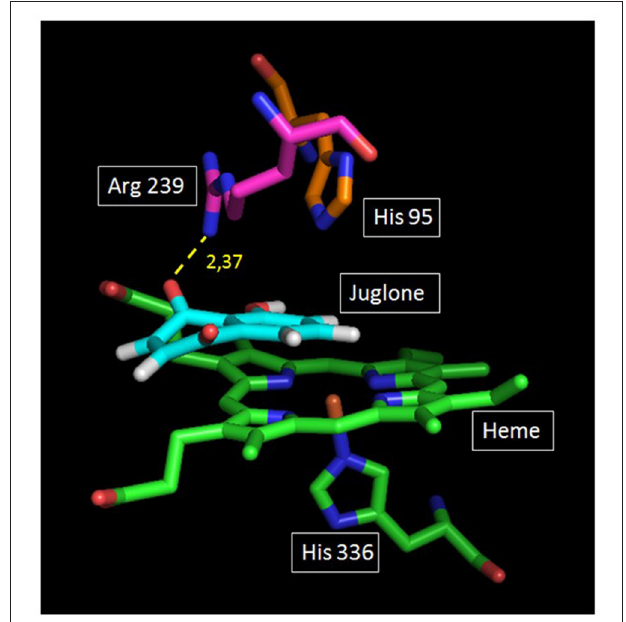
FIGURE 6 | Plausible docking solution of juglone and human myeloperoxidase (MPO) analyzed by GOLD. Green and blue atoms represent the heme and the amino acid (His-336) located below the heme. On top of the heme are two other amino acids of the apoprotein structure (Ar-239 and His-95). Juglone is in light blue color . The yellow dashed line represents the juglone–MPO Arg-239